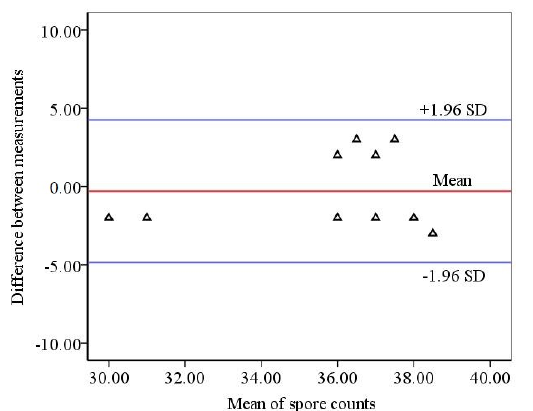
Figure 9. Analysis by Bland–Altman method, the triangles in the figure represent data for count- ing